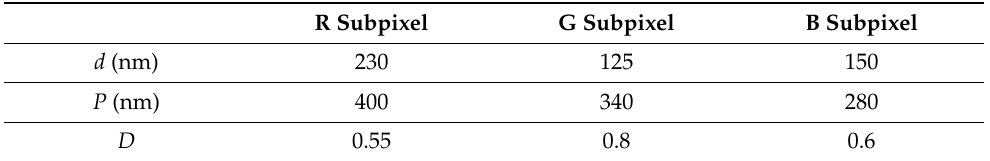
Table 1. Grating subpixel parameters (height d , period P , and duty cycle D ) for the generation of red, green, and blue colors.